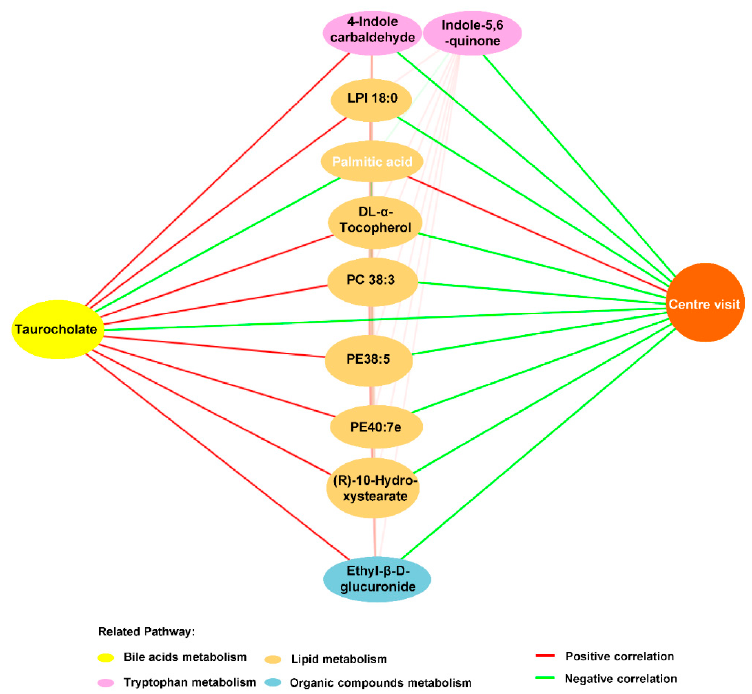
Figure 8. OCA-reversed bile acid taurocholate linked disordered serum metabolites to anxiety-like behavior in HFHS diet mice. Correlation network exhibited that microbial metabolites, including bile acid taurocholate and indole derivatives of tryptophan metabolites, linked the metabolic disturbance to anxiety in HFHS diet mice, which were improved by OCA supplementation. Note: The serum metabolites are color-coded according to the KEGG pathway mapping results, and metabolites marked with black color are increased, and white are decreased in HFHS diet mice. Positive correlations are illustrated as red lines and negative correlations as green lines. Abbreviations: HFHS, high-fat high-sugar; OCA, obeticholic acid; KEGG, Kyoto Encyclopedia of Genes and Ge-